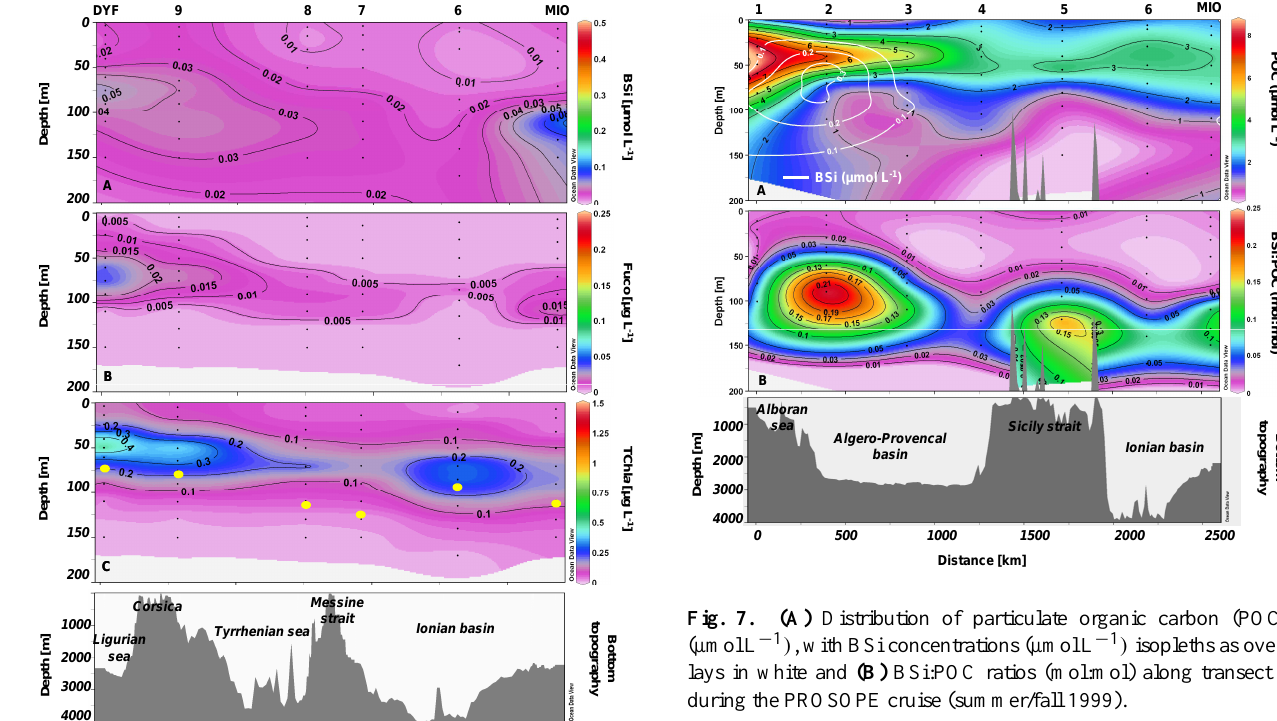
Fig. 6. Distribution of (A) Biogenic silica (BSi) (µmolL − 1 ) , (B) Fucoxanthin (Fuco) (µgL − 1 ) , and (C) Total chlorophyll- a (TChl- a ) (µgL − 1 ) and depth (m) of the euphotic zone (yellow dots) along transect 2 during the PROSOPE cruise (summer/fall 1999).